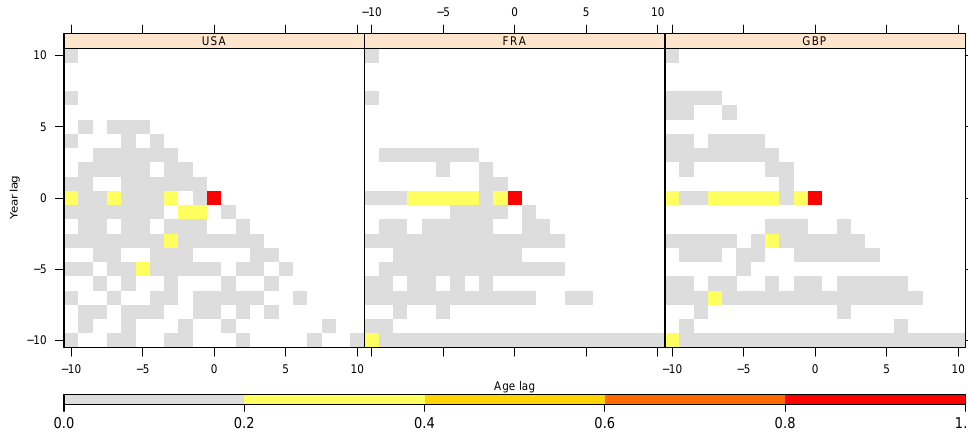
Figure A1. Autocorrelation: Inspection of spatial autocorrelation of the residuals (cid:98) ξ s using the definition of the spatial autocorrelation function given in Equation (16).